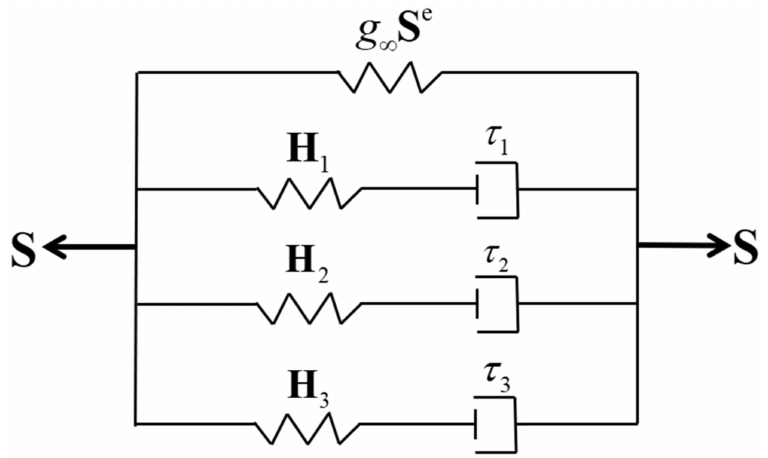
Figure 7. Three-element Maxwell relaxation